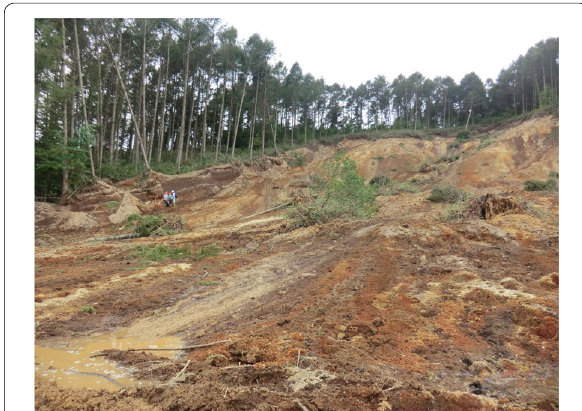
Fig. 6 A photographic image of a landslide, taken on the day after the earthquake at the location marked by a red square in Fig. 3. The base of Ta-d layer (orange–brown) was exposed over the landslide scar, indicating the location of a slip surface